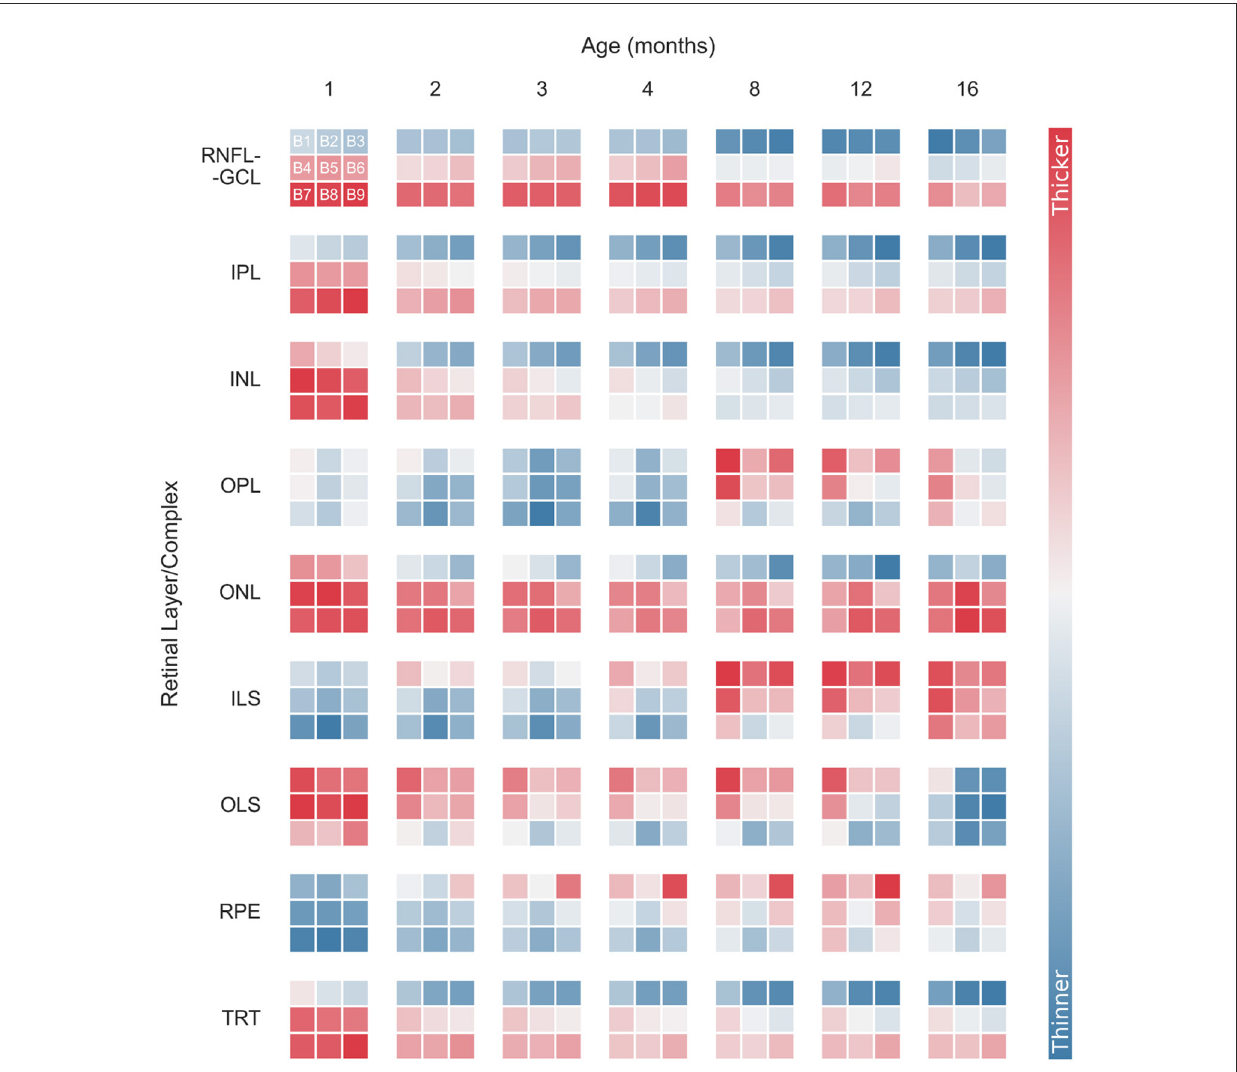
FIGURE6 Normalized longitudinal mean retinal thickness variations for wild-type mice, differentiated by layer and block (B1–B9). Data were normalized for each retinal layer/layer aggregates. Normalized thickness is indicated by the color bar. RNFL-GCL, retinal nerve fiber layer and ganglion cell layer complex; IPL, inner plexiform layer; INL, inner nuclear layer; OPL, outer plexiform layer; ONL, outer nuclear layer; ILS, photoreceptor inner segments; OLS, photoreceptor outer segments; RPE, retinal pigment epithelium; TRT, total retina